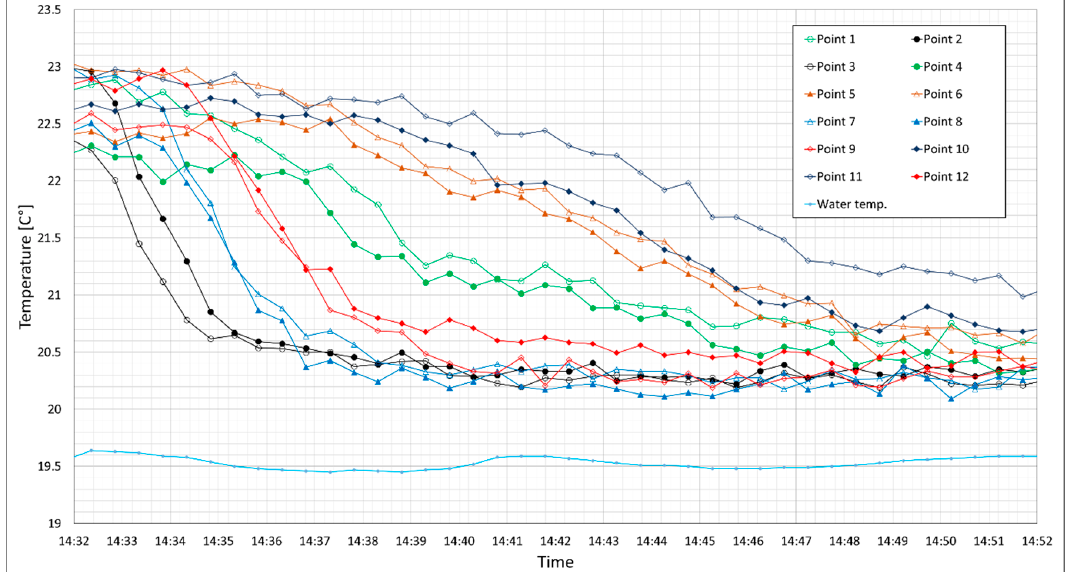
Figure 8. Temperature variation for measuring points.